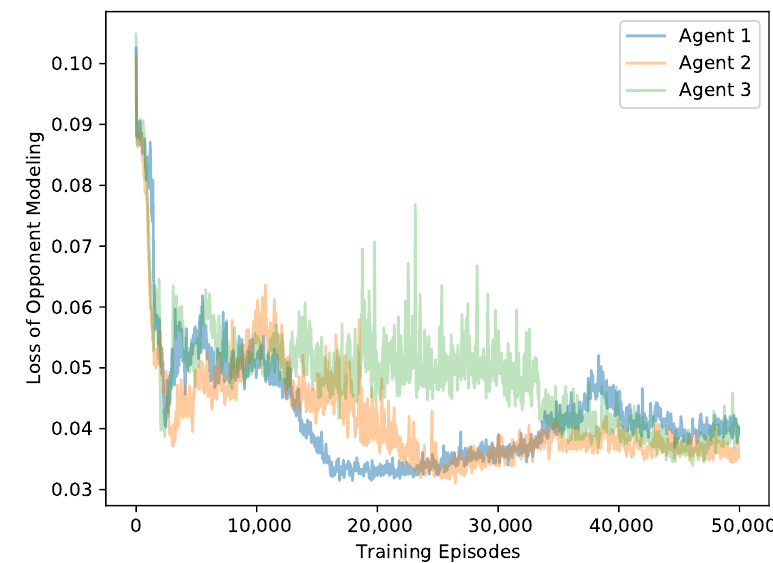
Figure 7. The loss curves of opponent models on